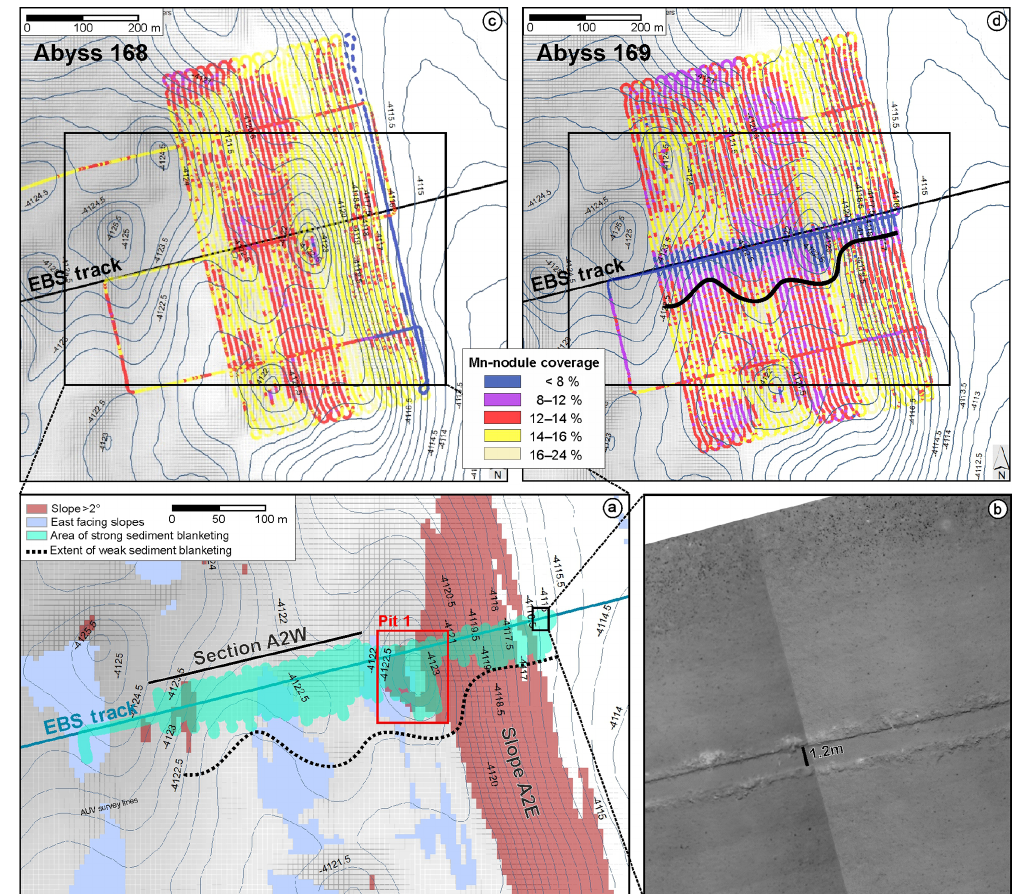
Figure 9. (a) The green shaded area in the detailed bathymetric map marks lowest nodule coverage sites, associated with the sediment cloud dispersal. The dashed black line represents the furthest extent of weak nodule blanketing. It corresponds to a nodule pixel color brightening and can be automatically computed from the imagery. Purple shading indicates east-facing slopes. Red shade marks areas with slope > 2 ◦ . The blue line marks the ideal track of the EBS deployment. (b) Extract from a photo mosaic created from AUV imagery; nodules are completely covered by sediment towards the sides of the tracks; approximately 10m north of the track, the sediment cover disappears within a sharp transition. Maps in panels (c) and (d) show the analyzed Mn-nodule coverage before ( c ; dive SO239_019_AUV2) and after ( d ; dive SO239_028_AUV3) the EBS